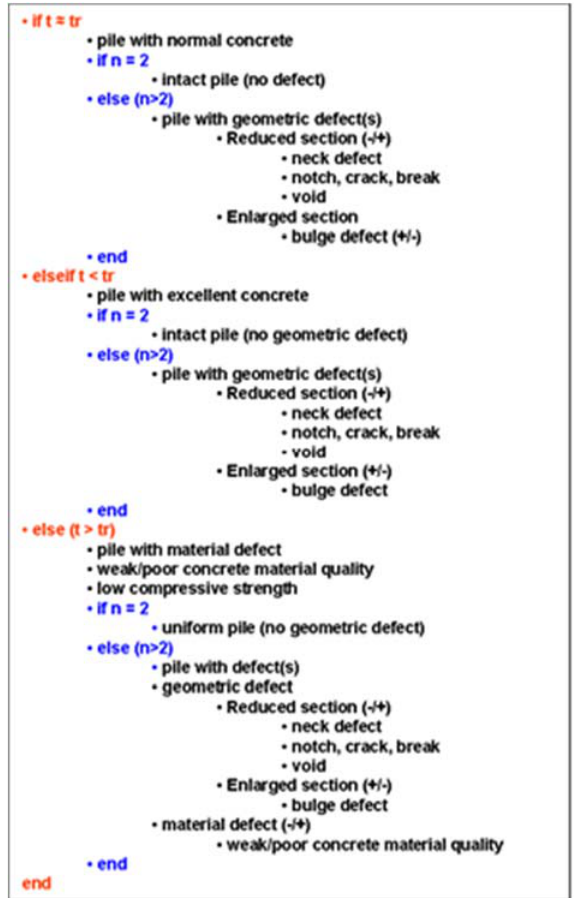
Figure 6. Pseudo ‐ code for pile defect diagnosis. Figure 6. Pseudo-code for pile defect